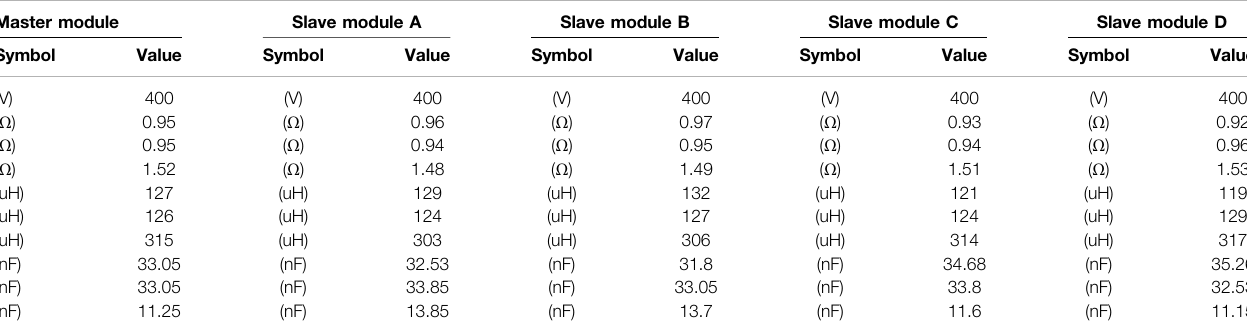
TABLE 1 | Parameters of the modular WPT system. Master